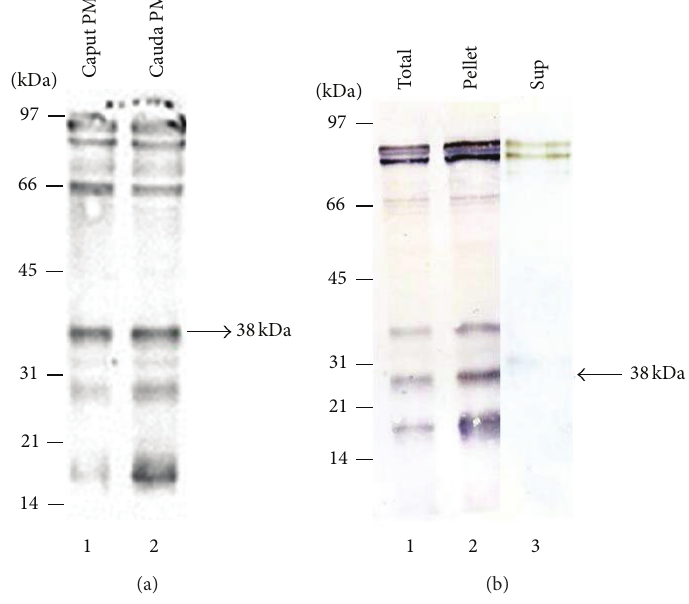
Figure 2: (a) RCA binding glycoproteins in plasma membranes (PM) of caput and cauda epididymal spermatozoa. Both caput (lane 1) and cauda (lane 2) plasma membrane fractions exhibited several major RCA binding polypeptides (94, 90, 66, 38, 29, and 18 kDa) in addition to several minor RCA binding polypeptides. The 38kDa polypeptide revealed the highest affinity to RCA among the several major RCA binding polypeptides. Each lane contained 10 𝜇 g protein. (b) The salt-dependent dissociation of 38 kDa RCA binding polypeptide of cauda sperm plasma membranes. Lectin blot stained with biotinylated RCA showing total plasma membranes (lane 1) and the high salt extracted pellet (lane 2) and the high salt soluble (lane 3) fractions obtained from cauda sperm plasma membranes. The 38 kDa RCA binding polypeptide is only associated with the high salt extracted